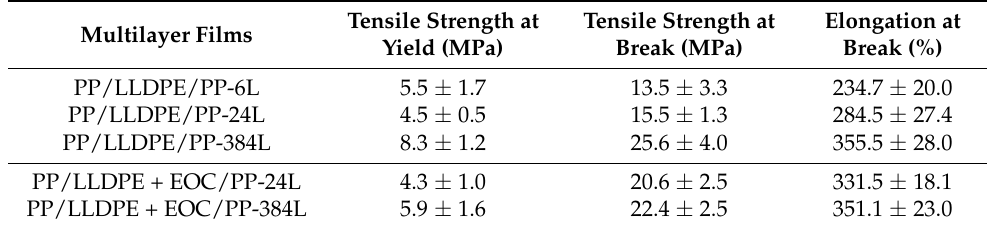
Table 3. Tensile strength properties in the machine direction (MD) of the PP/LLDPE/PP and PP/LLDPE + EOC/PP multilayer films with different numbers of layers.